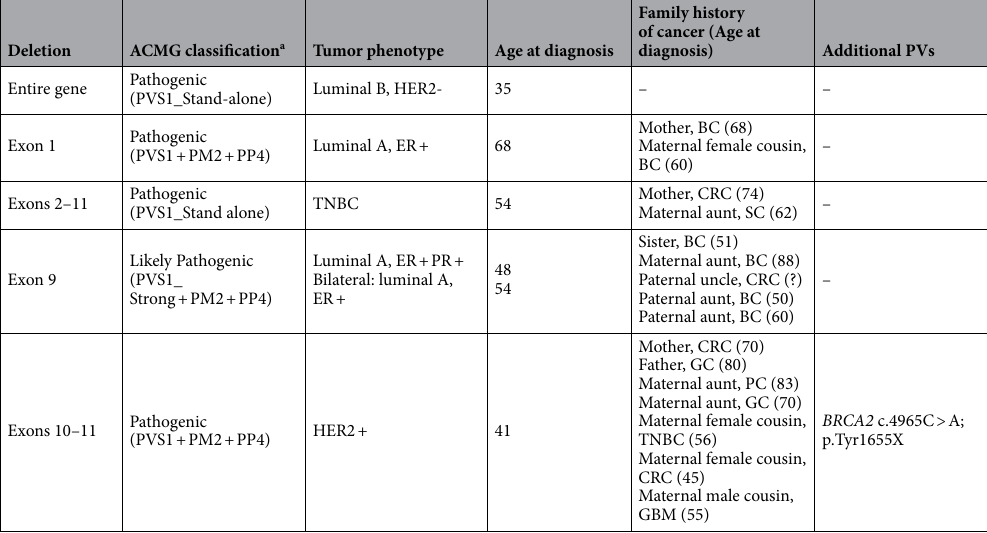
Table 1. Genotype and phenotype data of 5 BC patients carrying a large deletion in the BARD1 gene. PVS1 Pathogenic very strong 1, PM2 Pathogenic moderate 2, PP4 Pathogenic supporting 4, BC Breast cancer,